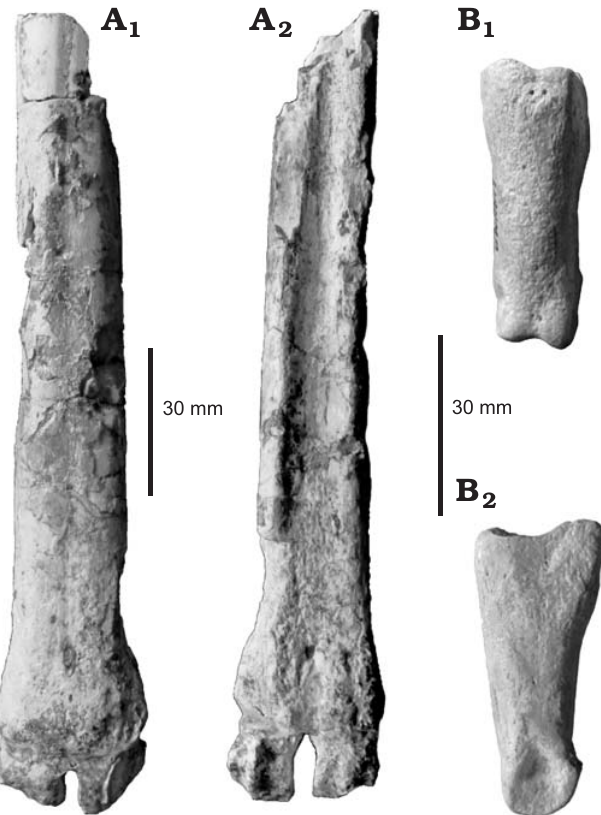
Fig. 6. Metacarpal and first phalanx of the cervid mammal Capreolus con- stantini Vislobokova, Dmitrieva, and Kalmykov, 1995 from the Pliocene of Hidalgo, Mexico. A . UAHMP 488, metacarpal, in anterior (A posterior (A ) views. B . UAHMP 489, first phalanx, in anterior (B 2 medial (B ) 2